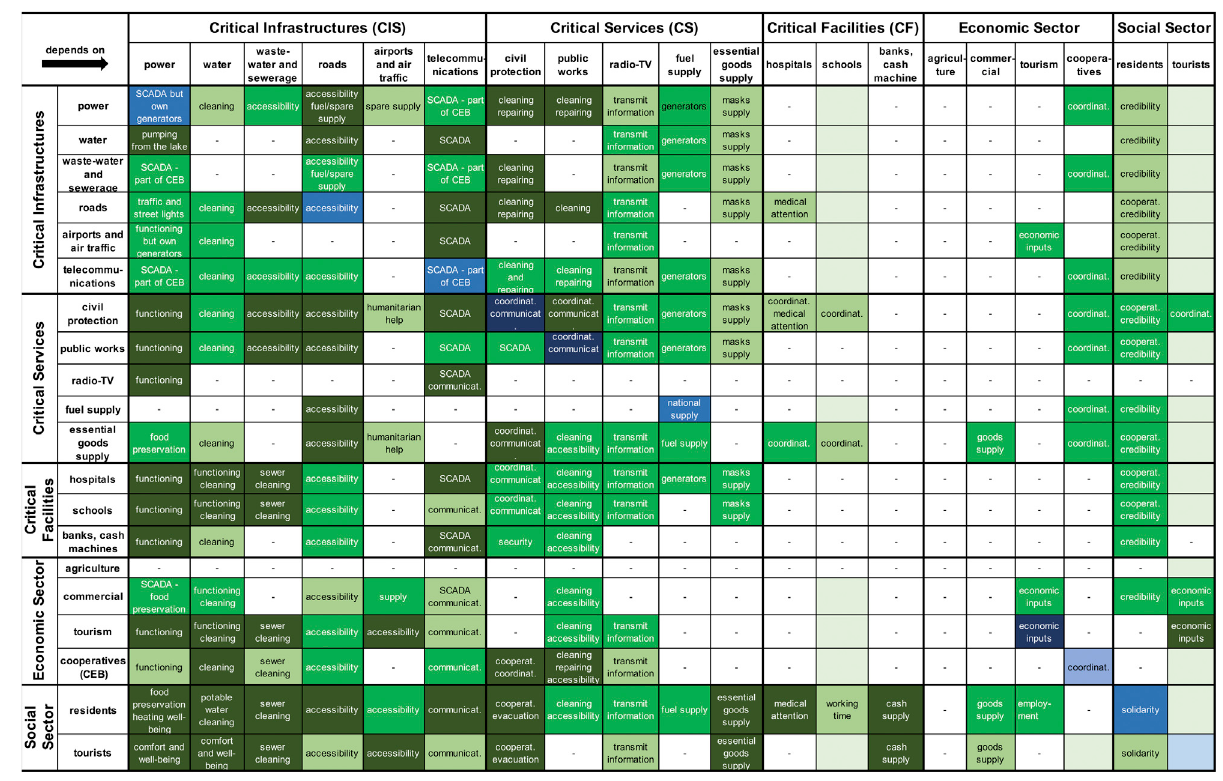
4 , show that the power system, roads,